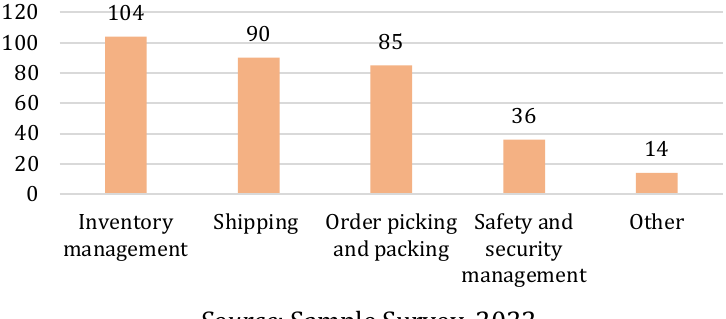
Source : Sample Survey,